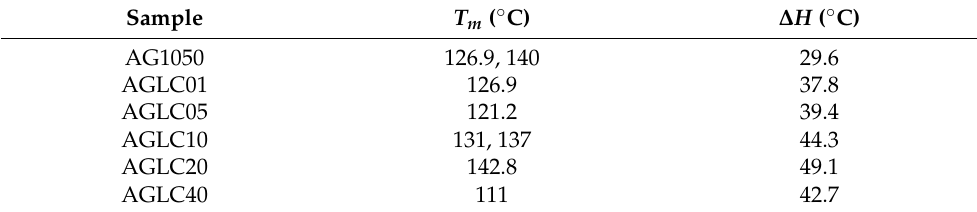
Table 3. Thermal analysis of the